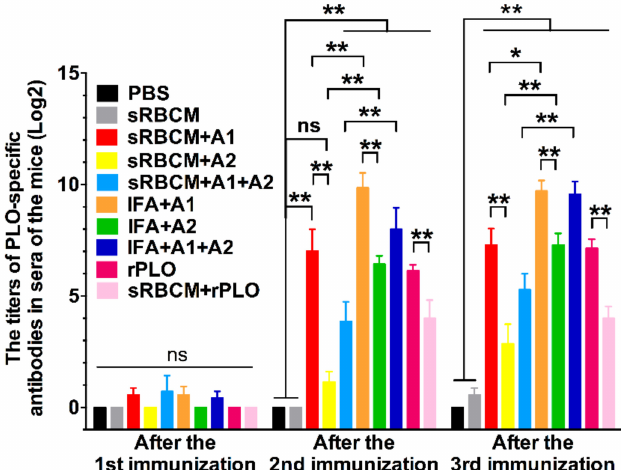
Figure 4. Titration of rPLO-specific IgG in sera of immunized mice by ELISA. sRBCM-trapped recombinant proteins were not as potent as incomplete Freund’s adjuvant (IFA) emulsified recombinant proteins in inducing rPLO-specific IgG. Compared with tPLOA2 (A2), tPLOA1 (A1) was more potent in eliciting rPLO-specific IgG in mice. Binding to sRBCM significantly reduced the potency of rPLO in eliciting rPLO-specific IgG. (* p < 0.05; ** p < 0.05; ns: not